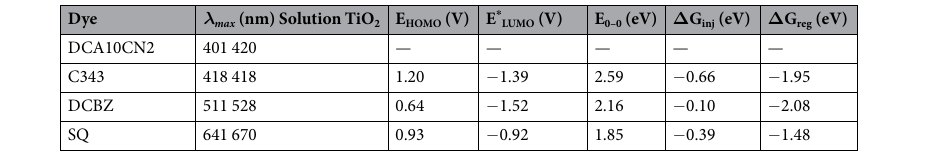
Table 1. Optical and electrochemical data for dyes used in this